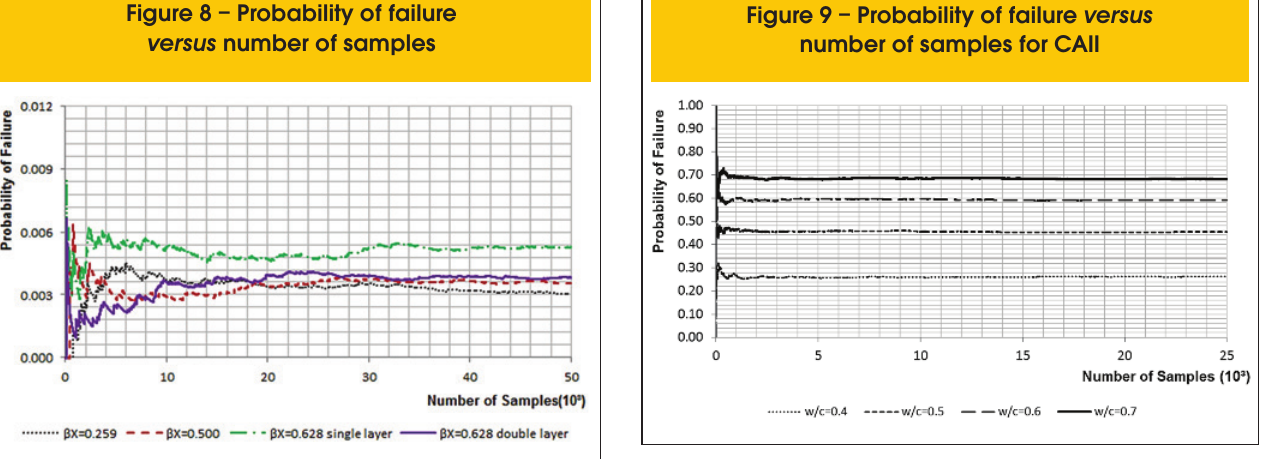
Figure 8 – Probability of failure versus number of samples